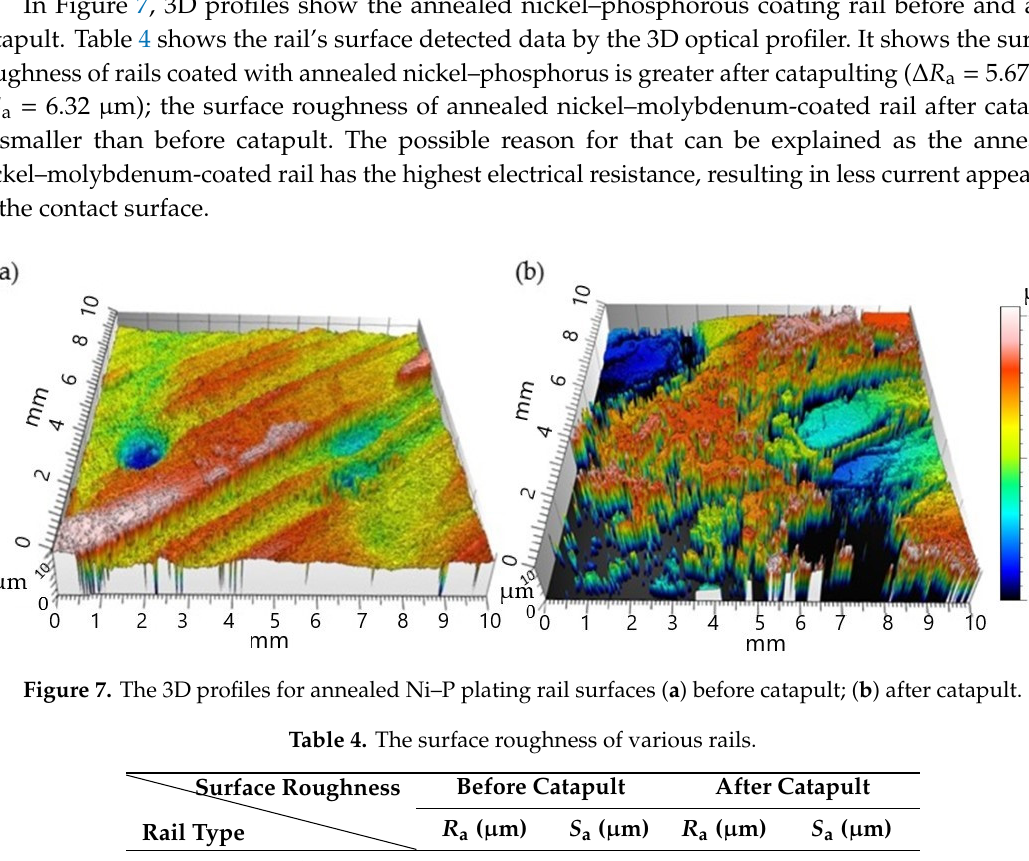
Figure 6. Ratio of ablated area to the rail area after catapult test.